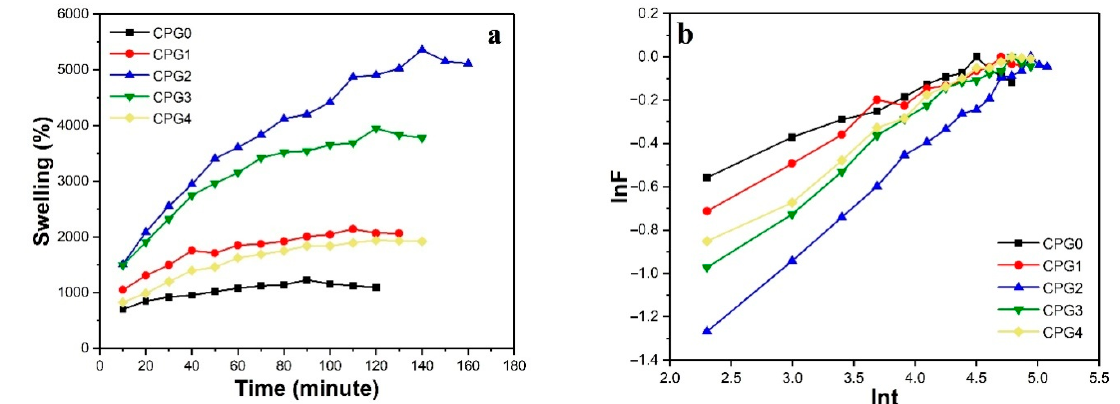
Figure 3. ( a ) Time vs. %swelling of CPG0, CPG1, CPG2. CPG3 and CPG4 hydrogels in DI water and ( b ) lnF vs. lnt (t) for CPG0, CPG1, CPG2. CPG3 and CPG4 hydrogels.